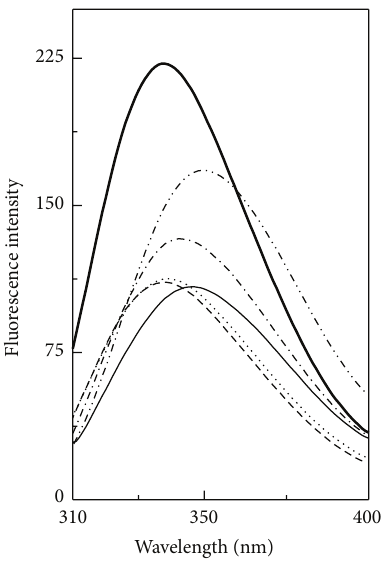
Figure 6: Tryptophan fluorescence spectra of the native (thick curve) and the thermal-denatured GAs in the absence (thin curve) and the presence of 2.6 M GLC (dashed curve), 1.3M TRE (dotted curve), 8 M GLY (dashed with one dot curve) and 8M EG (dashed with two dots curve). The spectra of thermal-denatured GA were recorded after equilibrating the sample at 71 ∘ C for 6 min, using a protein concentration of 0.12 𝜇